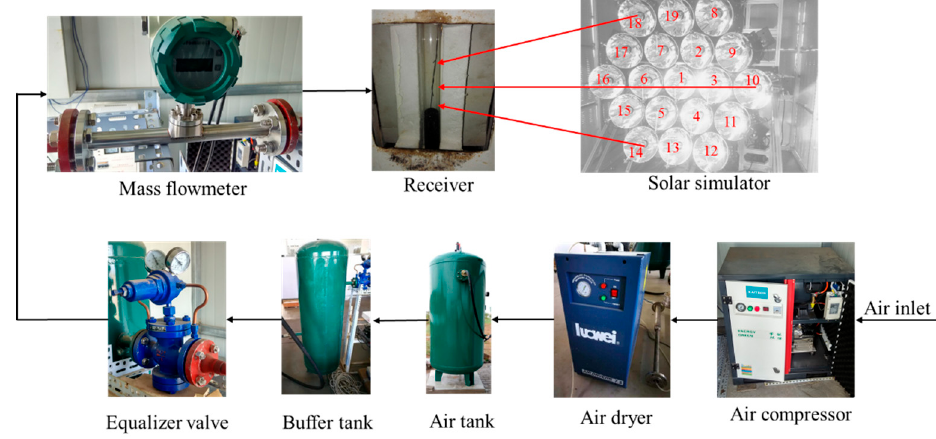
Figure 1. Schematic diagram of the experimental bench.